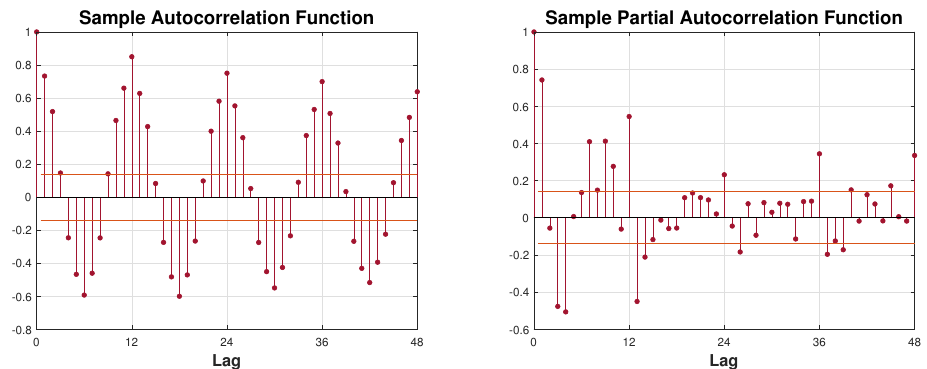
Figure 5. Graphs of autocorrelation and partial correlation of the MEL time series for Poland ( lag means delay l ).